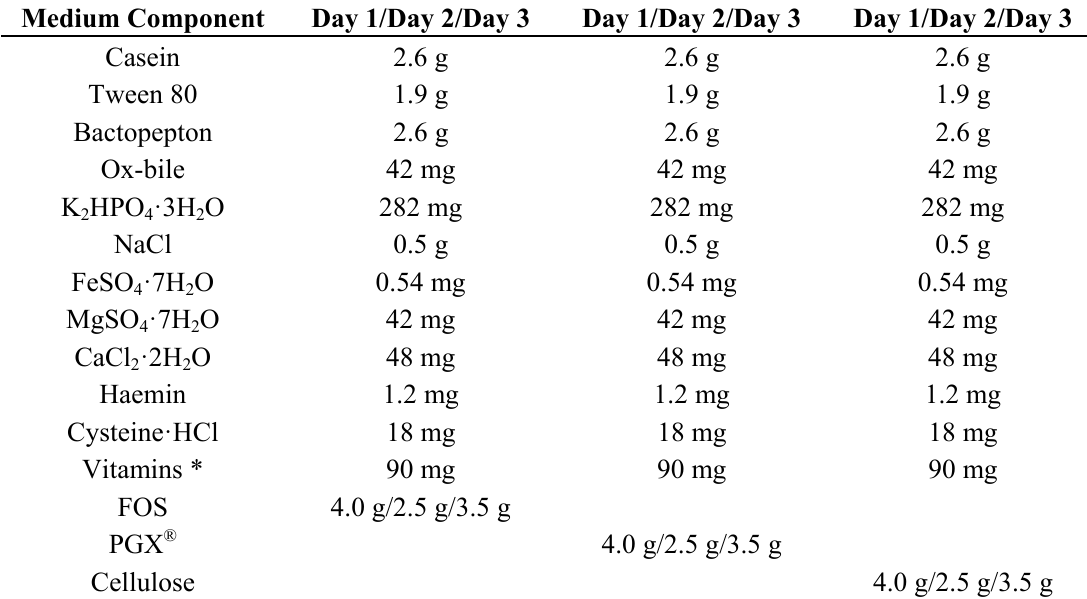
Table 1. Composition of media with control and test